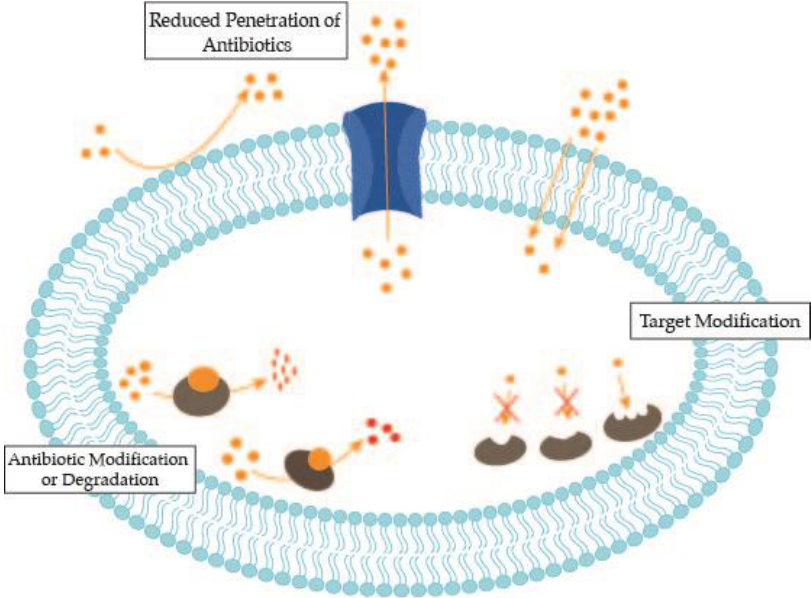
Figure 1. Mechanisms used by bacteria to resist antimicrobials.